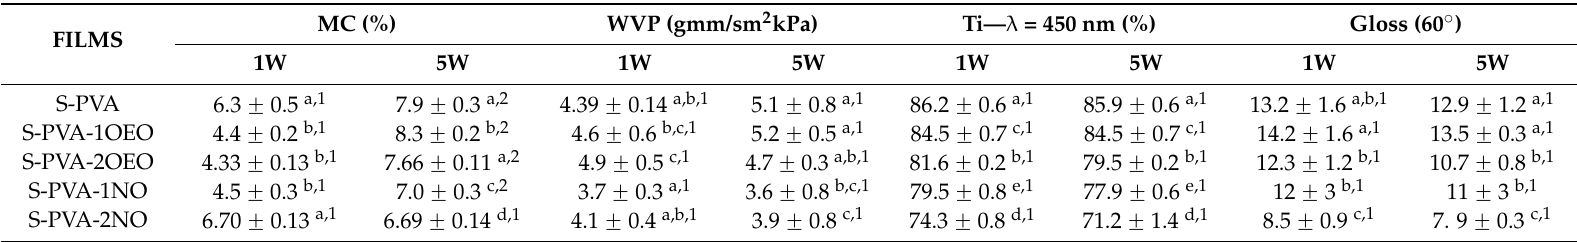
Table 2. Moisture content (MC), water vapour permeability (WVP), internal transmittance at 450 nm (Ti) and gloss at 60 ˝ incidence angle of blend control and oil composite